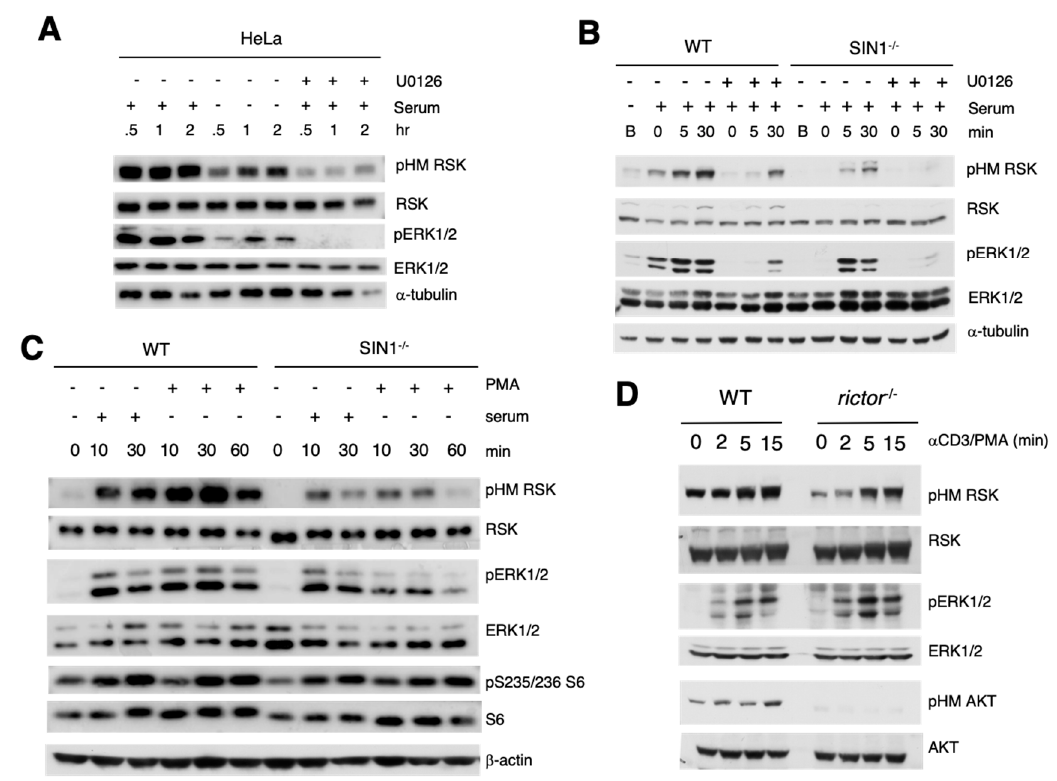
Figure 2. ERK activation is essential but not sufficient for full RSK HM site phosphorylation. ( A ) HeLa cells were resuspended in complete media without serum in the presence or absence of 15 μ M U2016 for the indicated times. 1× FBS (serum) was added as indicated, at the last 0.5 h before harvest. Cells were harvested in CHAPS lysis buffer and protein extracts were subjected to SDS-PAGE and immunoblotting using indicated antibodies. ( B ) Wild type (WT) or SIN1 − / − MEFs were grown in complete DMEM (Basal; B) or grown then serum-starved overnight. Serum was re-added and cells were incubated for the indicated times (min). Cells were harvested and processed as in ( A ). ( C ) WT or SIN1 − / − MEFs were grown overnight in the absence of serum, followed by addition of serum or PMA for the indicated times. ( D ) WT or rictor − / − thymocytes were non-stimulated (0) or stimulated with Anti-CD3 and 10 ng / mL PMA for the indicated times (min).